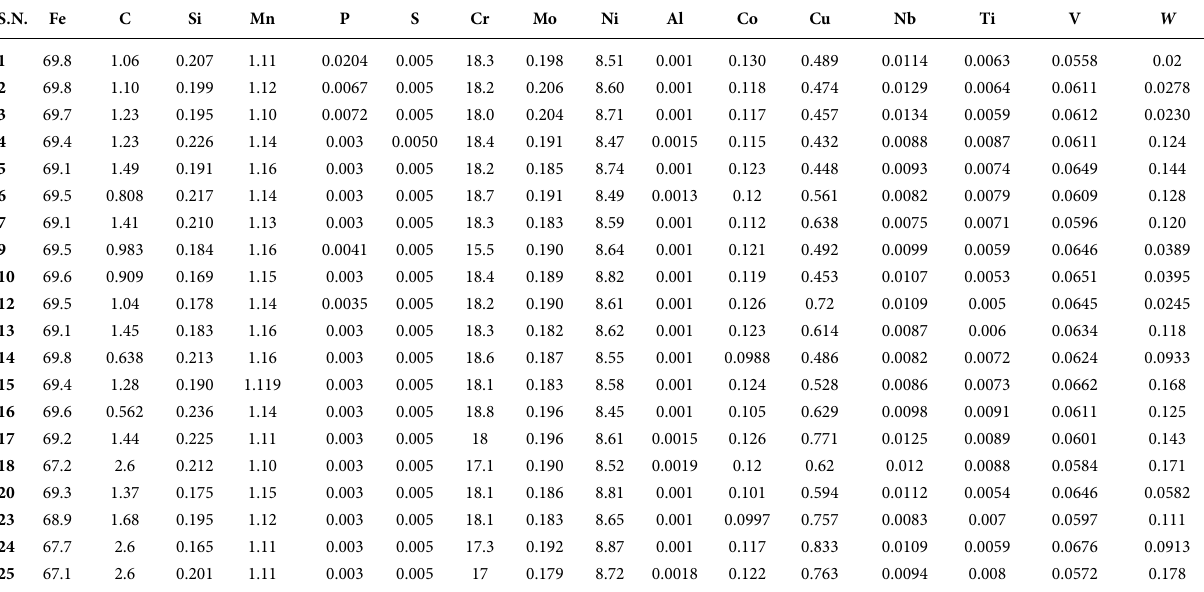
Table 5. Chemical composition (wt. %) of workpiece after